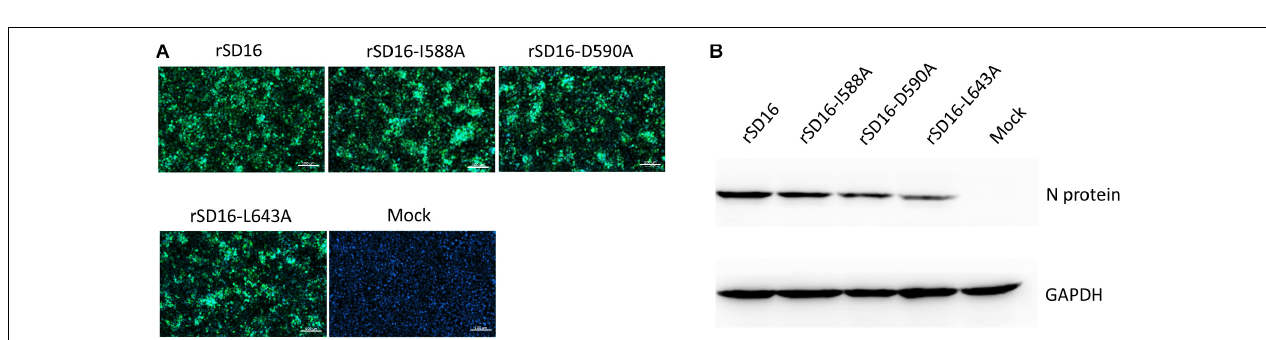
FIGURE 5 | Identification of residues involved in the interaction between Nsp9 and Nb6 by ELISAs. (A) Binding efficiency of the WT and mutant Nsp9 to Nb6. 96-well microtiter plates were coated with the WT and mutant Nsp9 (200 ng/well). After incubation with biotinylated Nb6, bound proteins were detected by HRP-conjugated streptavidin. (B) Binding efficiency of the WT and mutant Nb6 to Nsp9. 96-well microtiter plates were coated with the WT and mutant Nb6 (200 ng/well). After incubation with biotinylated Nsp9, bound proteins were detected by HRP-conjugated streptavidin. The binding efficiency was calculated on the basis of optical density (OD 450 ). Assays were performed in triplicate and data are presented as means ± SD.